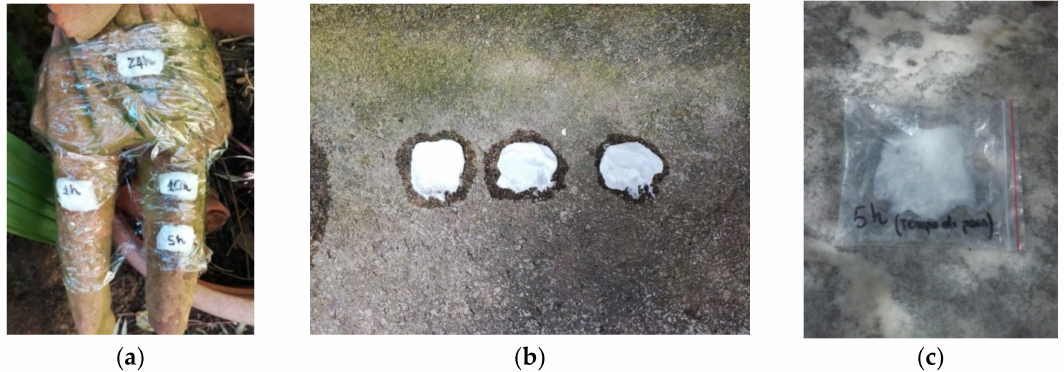
Figure 3. Application of Pickering emulsion on the surfaces: ( a ) ceramic, ( b ) cement grit, and ( c )